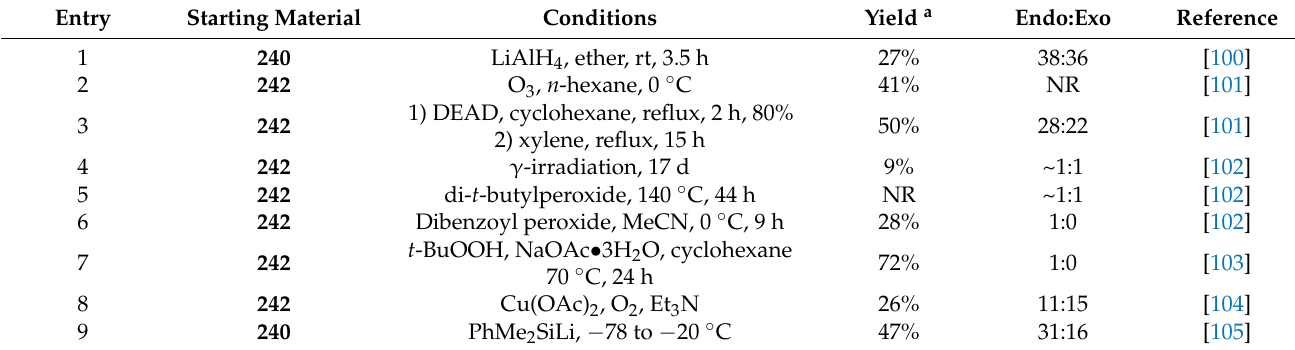
Table 3. Oxidative and reductive reaction conditions for formation of dipyrroloquinoline 241